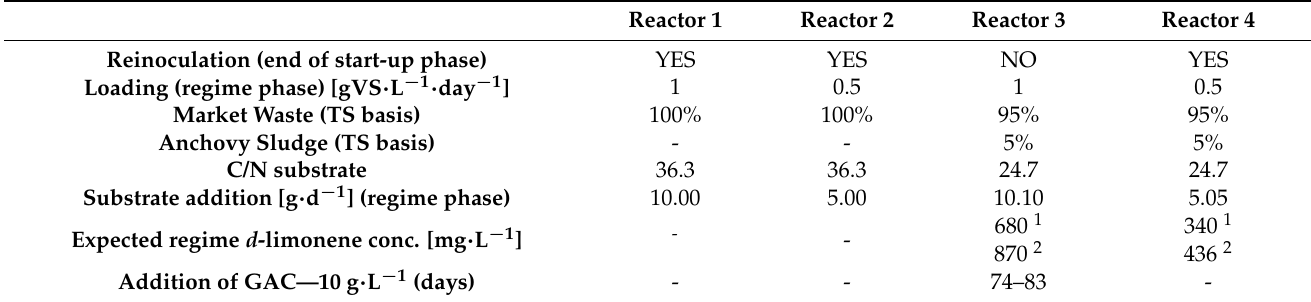
Table 3. Semi-continuous experiments.